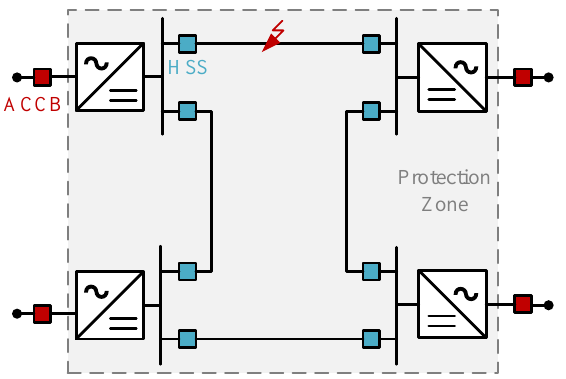
Figure 4. Protection zone of a non-selective fault clearing